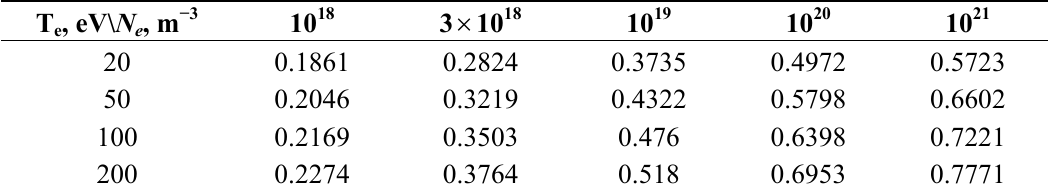
Table 2. The population redistribution coefficient K ( n , T level n = 4 for various plasma temperatures and